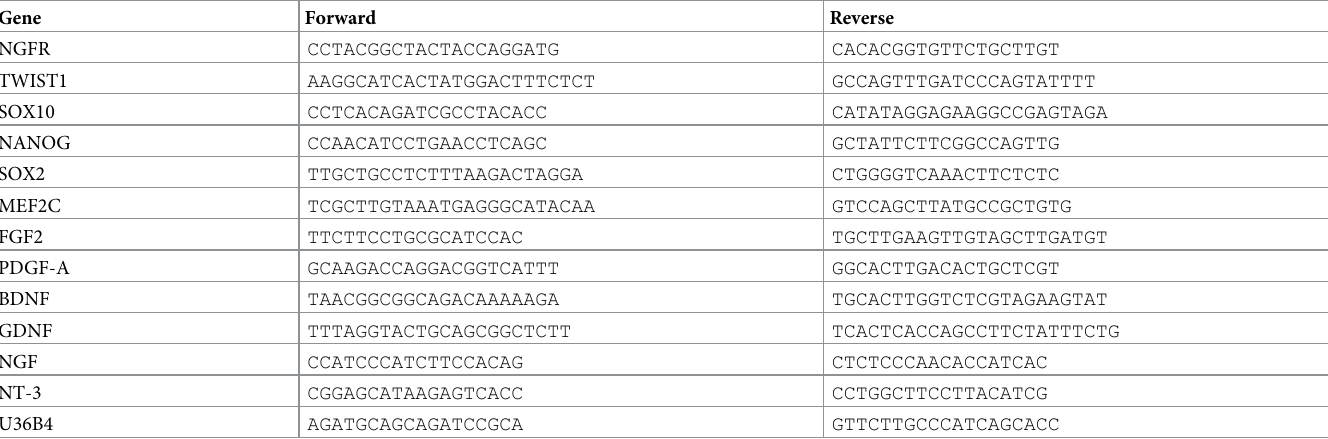
Table 1. qPCR primer